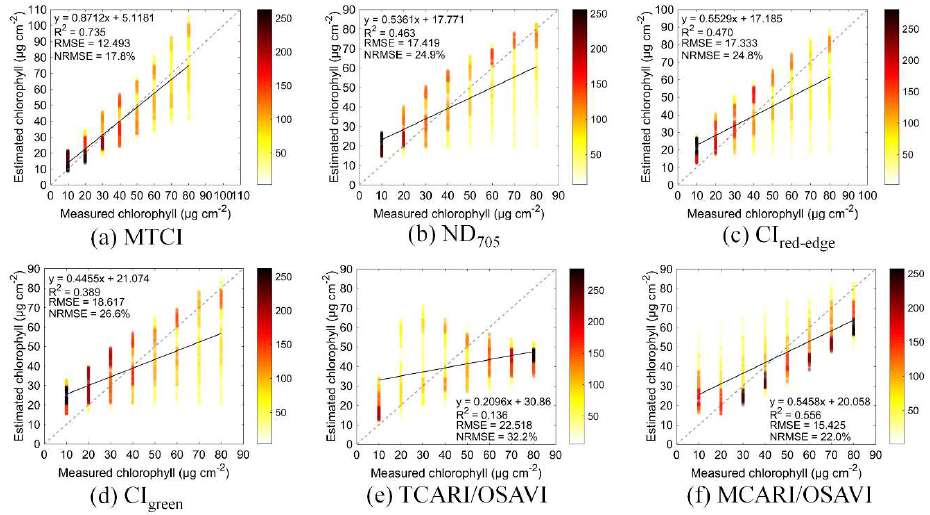
Figure 8. LCC retrieval performance using the indices MTCI, ND 705 , CI red-edge , CI green TCARI/OSAVI and MCARI/OSAVI calculated from the simulated dataset.